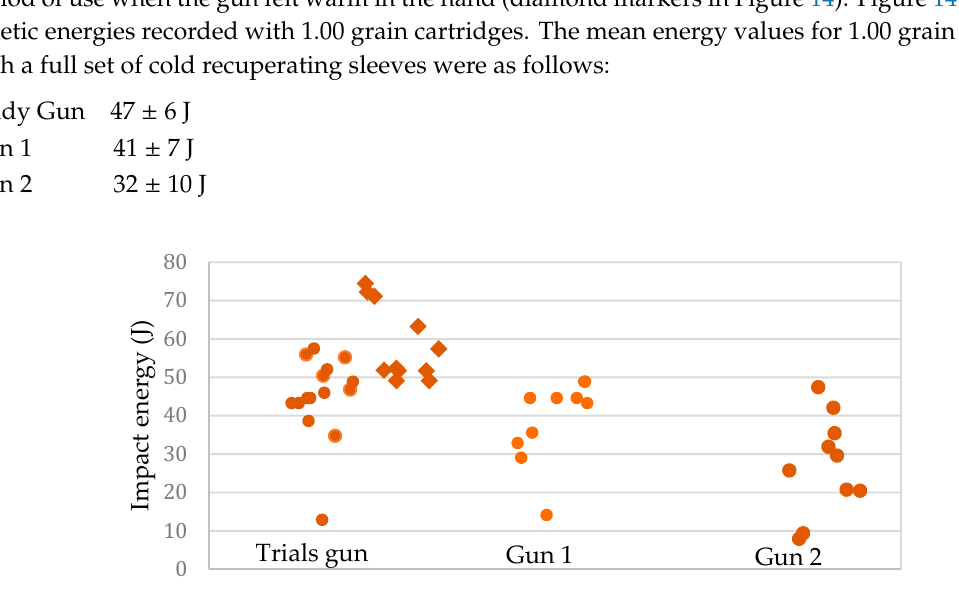
Figure 14. Impact energy for three Accles and Shelvoke Small Animal tools using brown 1.00 grain cartridges. Trial gun energies shown with recuperating sleeves cold (round markers) and warm (diamond markers).